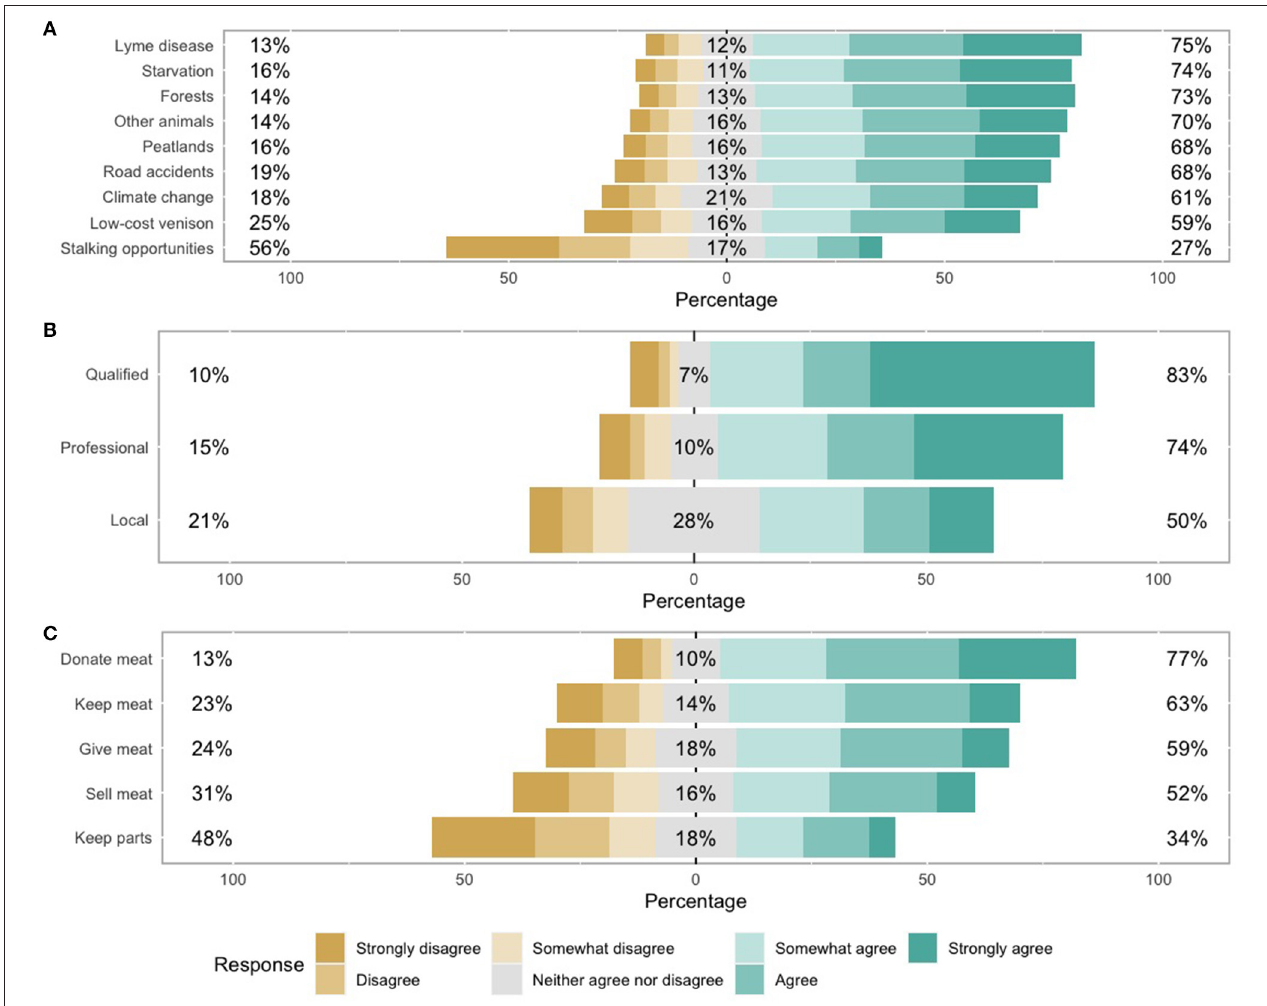
FIGURE 2 | Acceptability of shooting more deer if doing so would help achieve various socioeconomic and environmental objectives (A) , importance of people who shoot deer having certain characteristics (B) , and acceptability of using meat and other deer parts in various ways (C) . Bars show distribution of responses, colored by disagreement (browns), indifference (gray), and agreement (greens). Percentages show proportions of respondents who disagreed (left), were indifferent (middle), or agreed (right), after excluding “I don’t know”